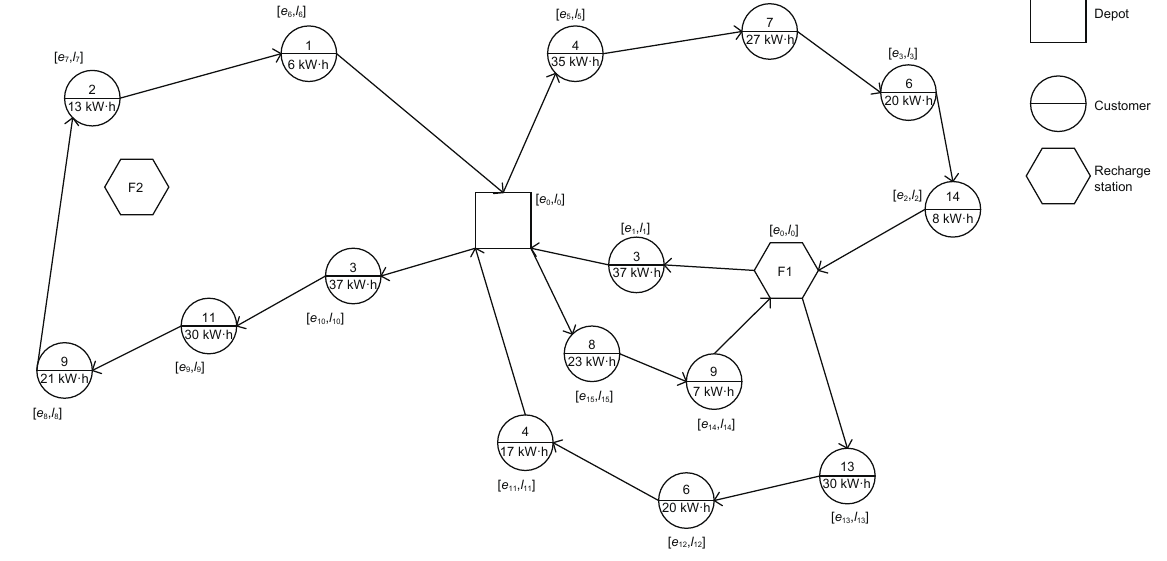
Fig. 1 Illustrative example for